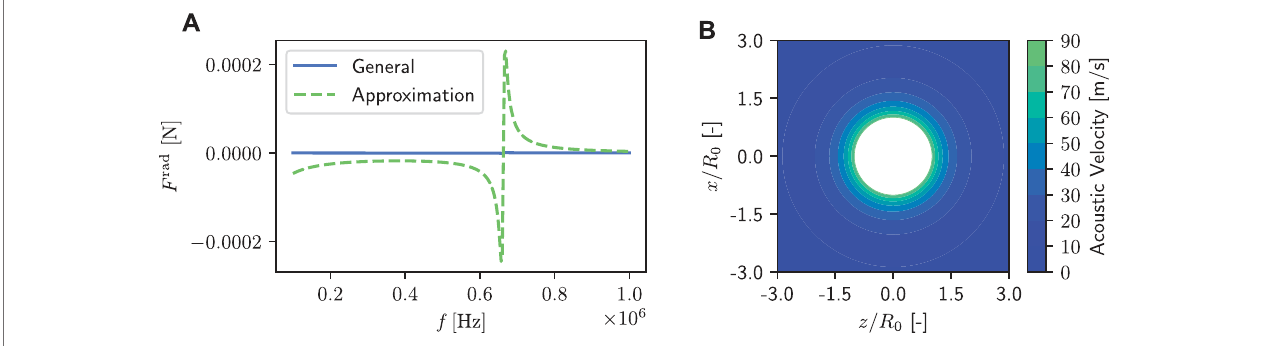
FIGURE 6 | ARF on an air bubble in water halfway between the velocity node and the velocity anti-node: (A) Comparison of the correct general expression of the ARF(solid,blue)andtheerroneoussmallbubbleapproximation (dashed, green).Thegeneralsolutionshowsthesamepeaksat resonancebutits magnitude isovertwo ordersofmagnitude smaller.The corrected smallbubblesolutionisnot plottedsince itisinverygoodagreementwiththe generalsolution. (B) Velocityamplitudes ofthe scattered acoustic fi eld close to resonance. At resonance, the acoustic scattering is dominated by the monopole mode.